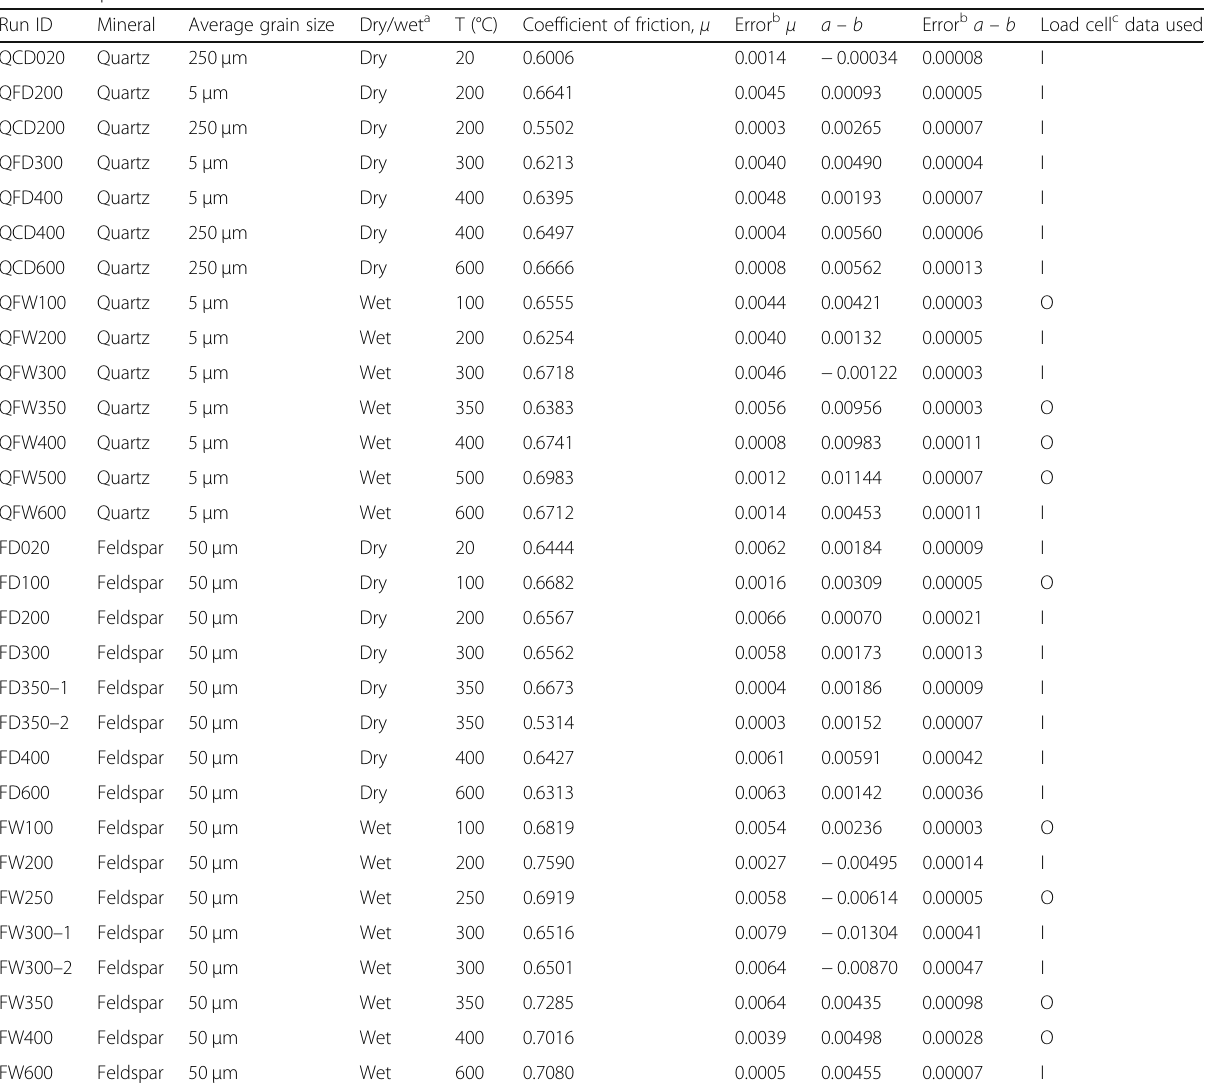
Table 1 Experimental conditions and results Run